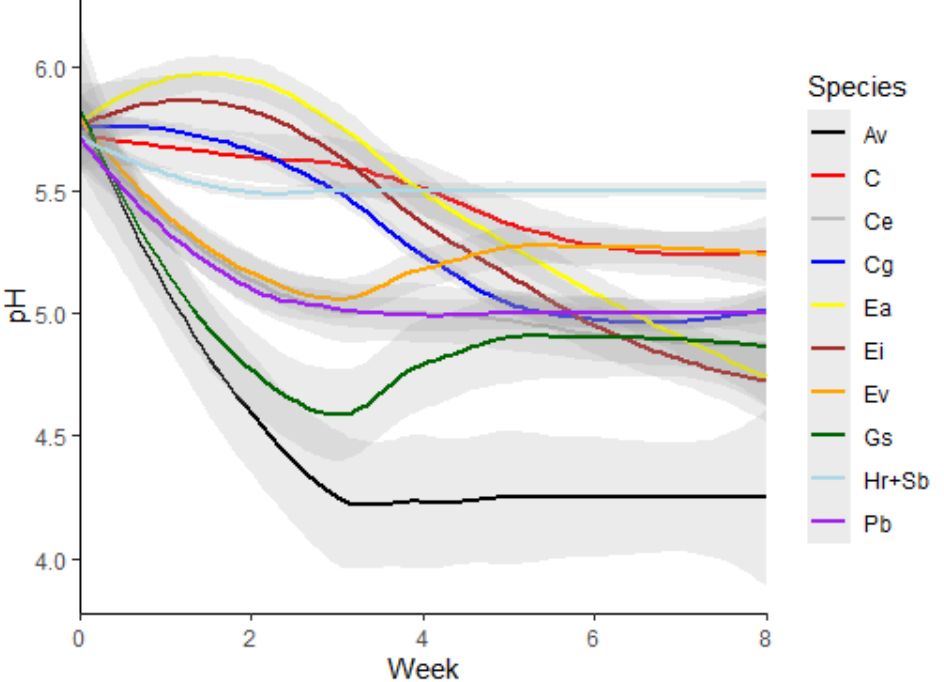
Figure 5. Average pH of the medium (with 95% confidence intervals shown in grey) combining the 1:1 and 1:3 bromocresol green:bromocresol purple combination results used at a concentration of 10 µ g mL − 1 over an eight week period (n = 2). Control (C), Anigozanthos viridis (Av), Commersonia erythrogyna (Ce), Conospermum galeatum (Cg), Eucalyptus argutifolia (Ea), Eucalyptus impensa (Ei), Eremophila virens (Ev) , Grevillea scapigera (Gs), Hemiandra rutilans and Symonanthus bancroftii (Hr+Sb), and Philotheca basistyla (Pb). Note: Hr and Sb showed the same pH readings over the eight week period.